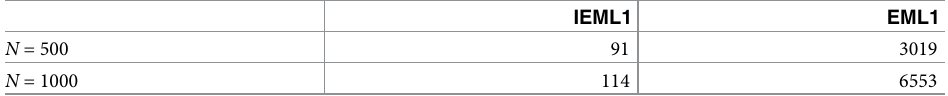
Table 1. The average CPU time in seconds for IEML1 and EML1 under K = 3 and J =